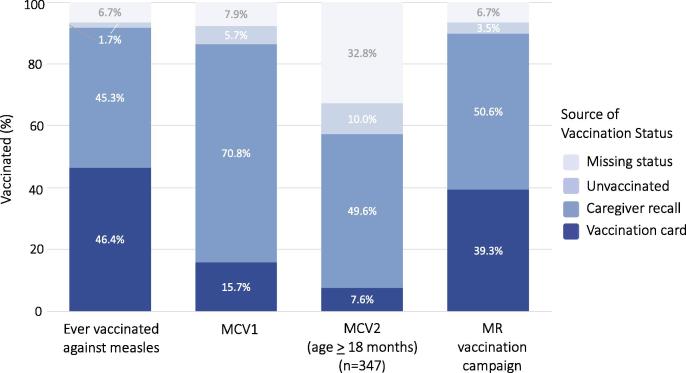
Measles and rubella vaccination coverage among children younger than 16 years of age (n = 368).Notes: MCV1: First dose of measles-containing vaccine from routine vaccination system. MCV2: Second dose of measles-containing vaccine from routine vaccination system among children ages 18 months or older at time of survey. MR: measles-rubella. Receipt of MR vaccination campaign dose recorded on campaign immunization cards. Routine MCV1 and MCV2 recorded on separate home-based immunization card. Children ever vaccinated for measles had evidence of MCV1, MCV2, or MR vaccination campaign dose. Some children were missing data on vaccination status: 1.1% ever vaccinated for measles and MR vaccination campaign, 2.7% for MCV1 and 11.0% for MCV2. Sum of coverage by vaccination card and caregiver recall may vary slightly from overall coverage reported in manuscript due to weighting.